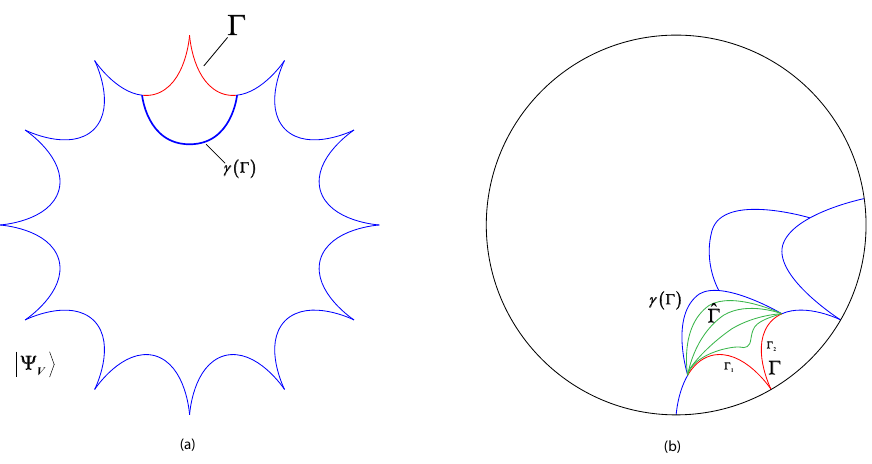
Figure 15 . (a) An example to illustrate the idea of generalized OSED method. (b) More general surface growth